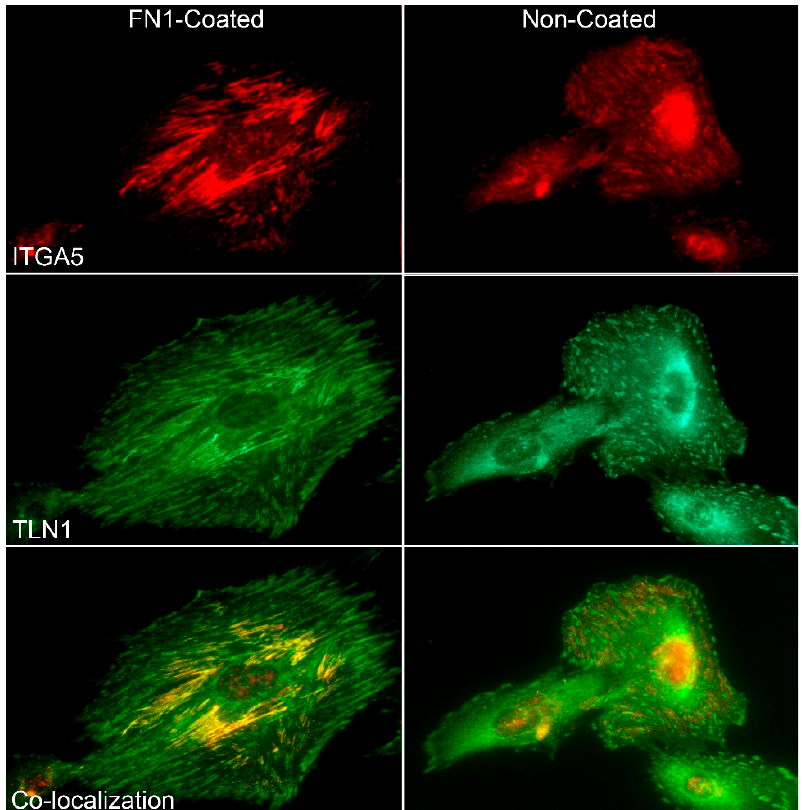
Figure 8. Immunofluorescence localization of the alpha 5 integrin (ITGA5) and talin (TLN1) on human myometrial cells bound to fibronectin (FN1). Cells were seeded on coverglass chambered slides